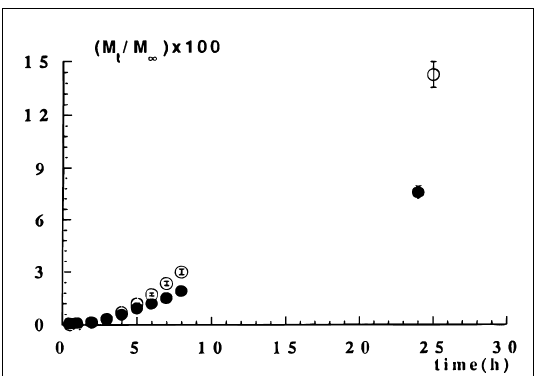
Figure 6. Diffusion profiles of TPH in distilled water ( ○ ) and in 0.9% NaCl (w/v) ( ● ) for the crosslinked polymer r =0.5 at 37 °C